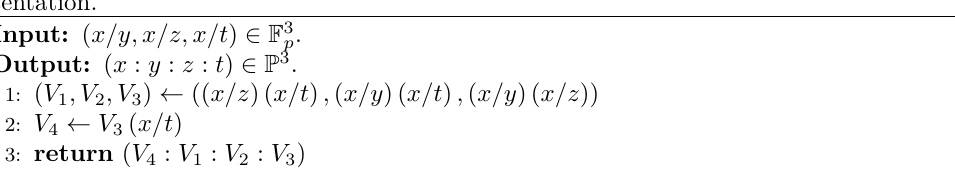
Algorithm 2 unwrap : ( x/y, x/z, x/t ) 7→ ( x : y : z : t ) unwrap point to its 508-bit repre-